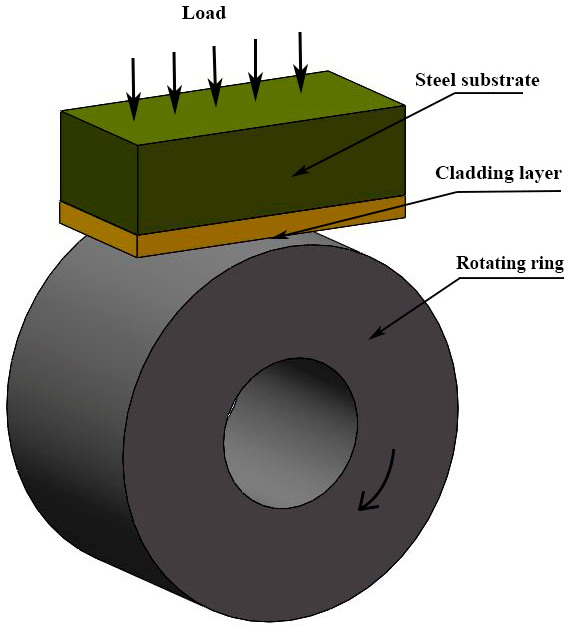
Figure 1. Schematic diagram of the wear tester.